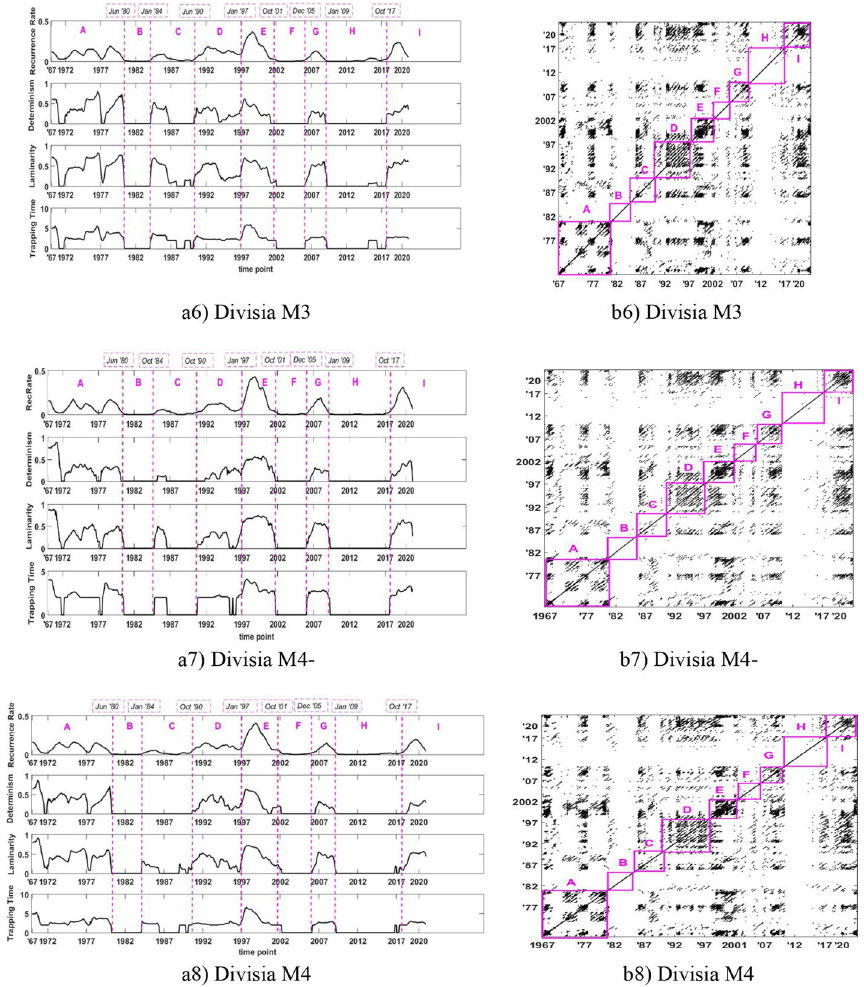
Fig. 6 RQA of the growth rates of broad Divisia monetary aggregates in Panel ( a ) in 611 quarterly rolling windows (the estimated dates (month/year) of phase transitions are shown on the top) and in Panel ( b ) in their RPs with